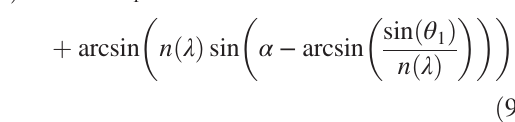
representing a good figure of merit for the optimization of the prism geometry. (iv) Large angles ( θ 1 and θ 0 2 in Fig. 6)